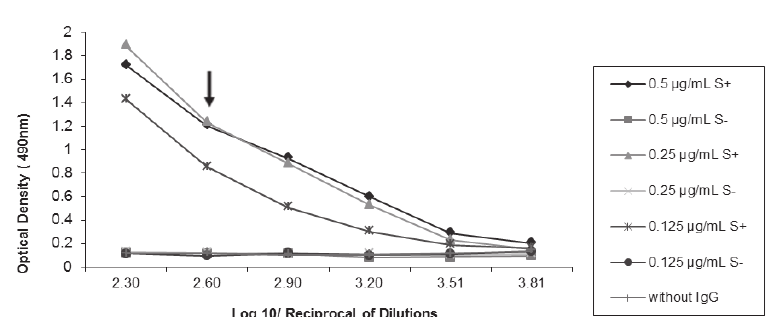
Figure 4 - Titration curves in an indirect ELISA assay sera from bovine IgG- immunized and non-immunized pacus. The pacu sera were serially diluted (1:200 to 1:6400) against bovine IgG antigen tested at different coating concentrations (0.5 to 0.125 μg/mL) and using an anti-pacu IgM polyclonal antibody (1:2000) as detector antibody. S+: Positive serum; S- : Negative serum. The arrow indicate the concentration of use for bovine IgG (antigen) and the dilution of use for pacu serum